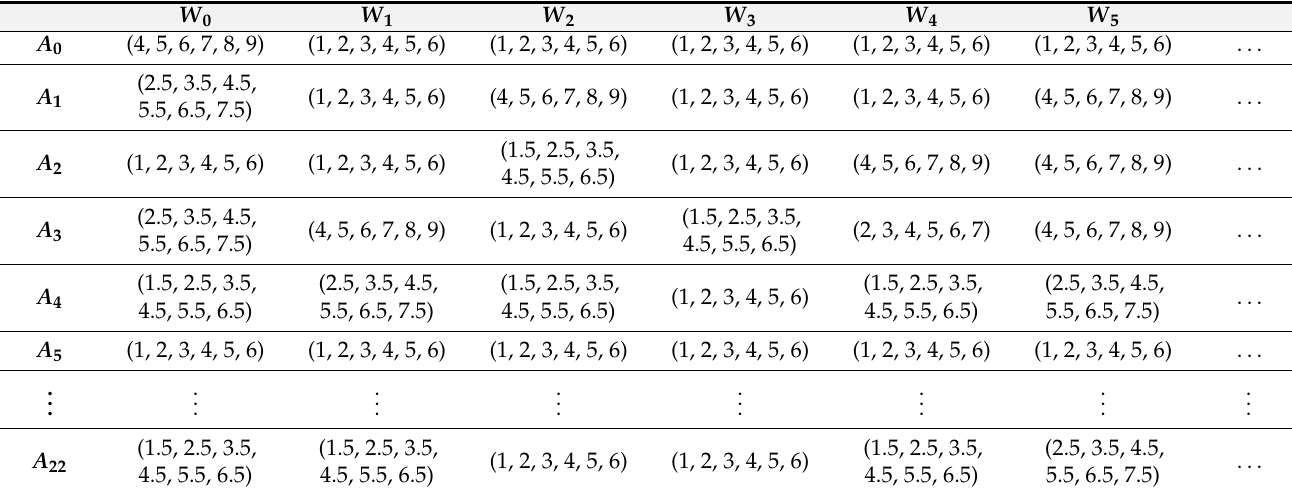
Table 8. The decision matrix using the